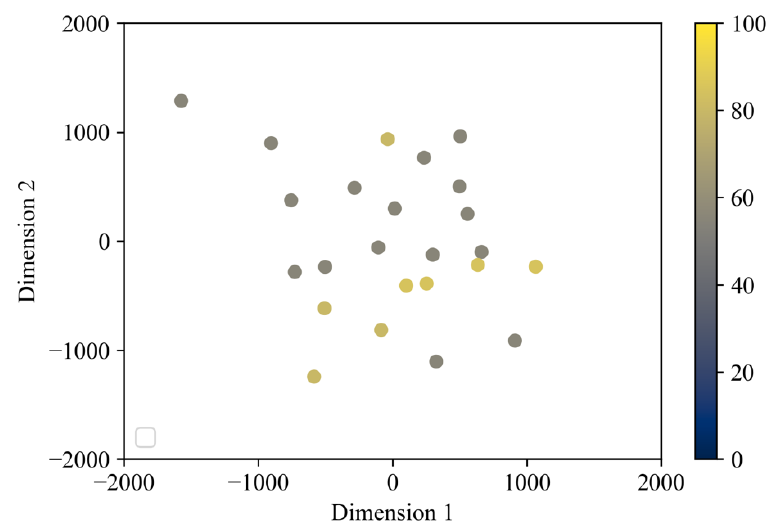
Figure 8. Standing behavior map categorized by BI.